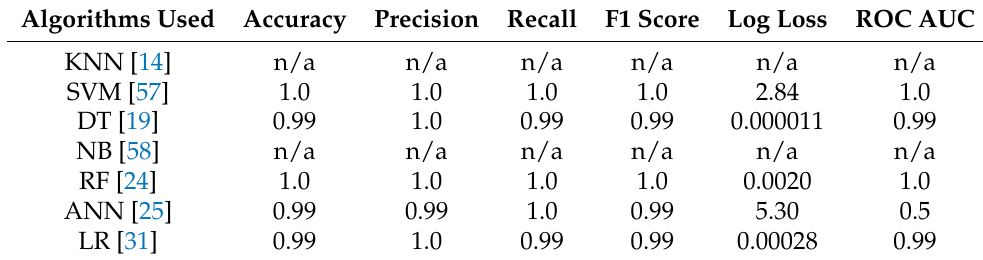
Table 20. DDoS UDP weighted classes